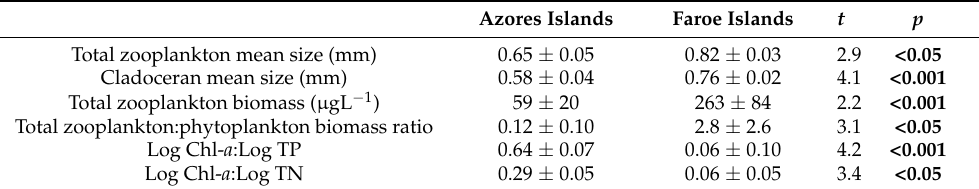
Figure 6. Fish community characteristics: mean size (cm) ( A ), mean size standardized by the maximum size reported in literature for each species (TL:Max TL) ( B ), and % of small fish × CPUE (%SF × CPUE) ( C ), and fish predation pressure indicators: chlorophyll-a:total phosphorus ratio (Chl- a :TP) ( D ), total zooplankton:phytoplankton biomass ratio (zoo:phytobiomass) ( E ), and mean size of cladocerans (Mean clad size) ( F ). In the Azores (red) and the Faroe Islands (blue); * p < 0.05 and ** p < 0.001, according to t -tests, deviation bars represent SE. Table 3. Fish potential predation pressure indicators, showing mean ± SE values in the two climatic regions and the results of statistical tests (in this case Student t